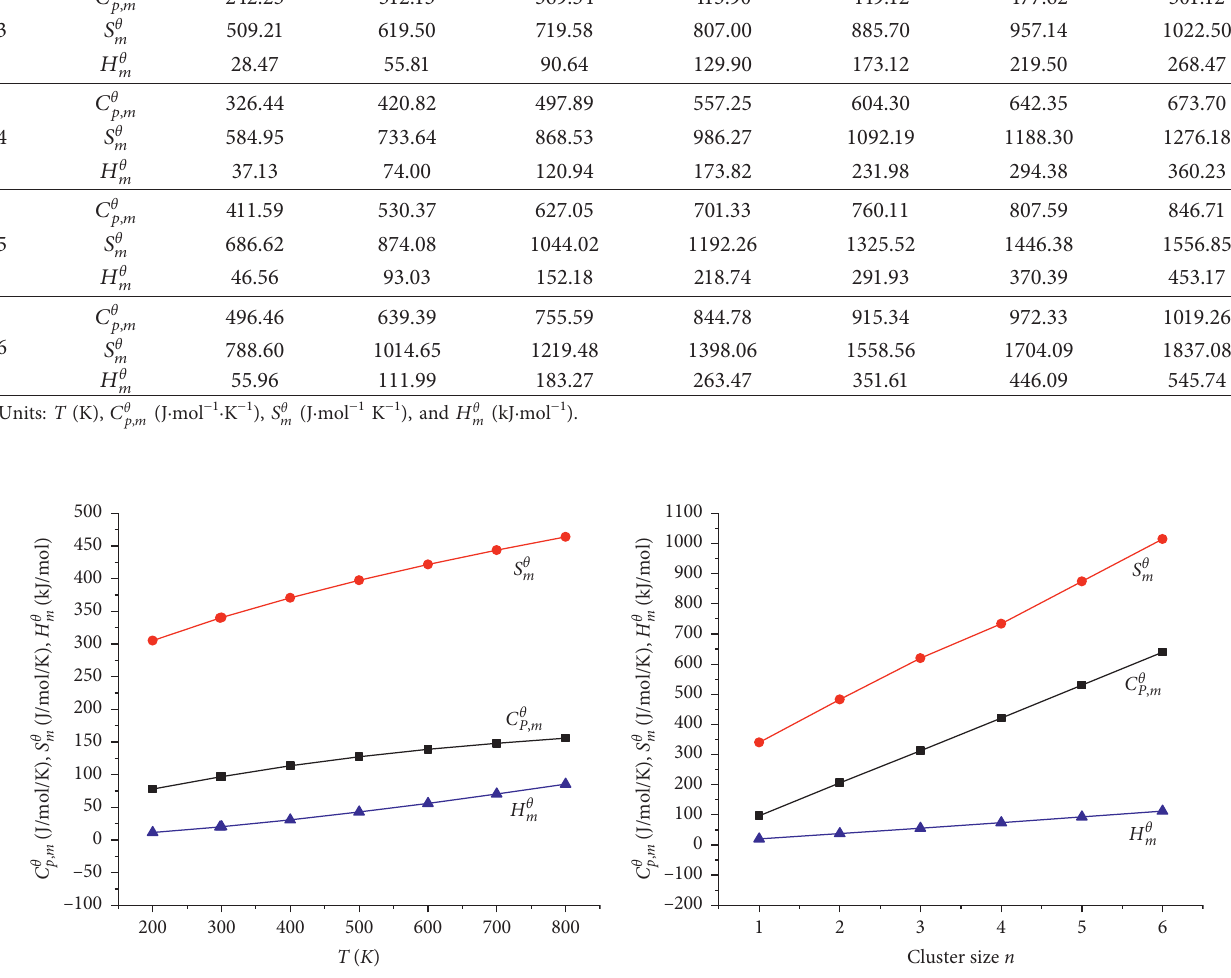
S θ H θ p,m , m , and m ) with the temperature ( T ) (a) for the monomer CH 3 FBN 3 and the